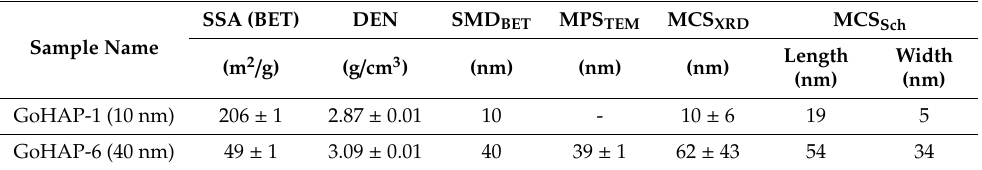
Table 1. GoHAP ™ characterisation. Specific surface area (SSA); skeleton density (DEN); mean particle size based on BET (SMD BET ); TEM histogram of log-normal curve (MPS TEM ); mean crystallite size